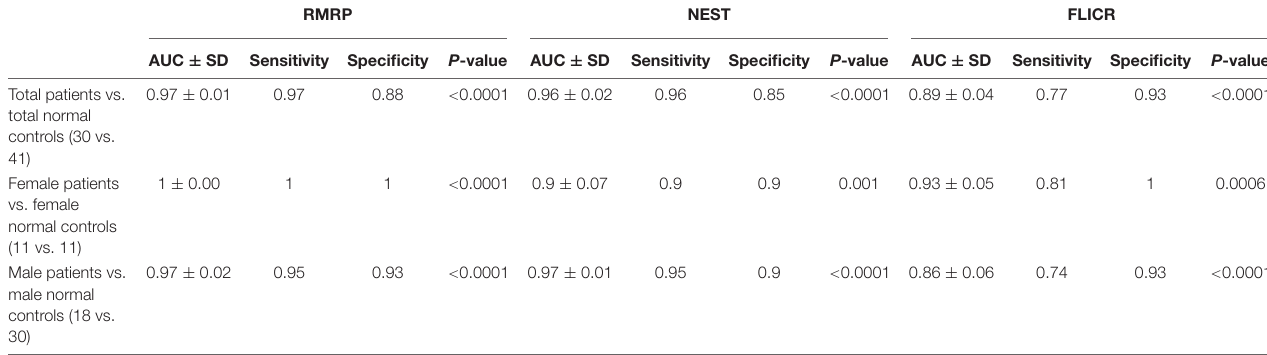
TABLE 5 | The results of ROC curve analysis in total patients with ASD as well as sex-based subgroups. RMRP NEST FLICR